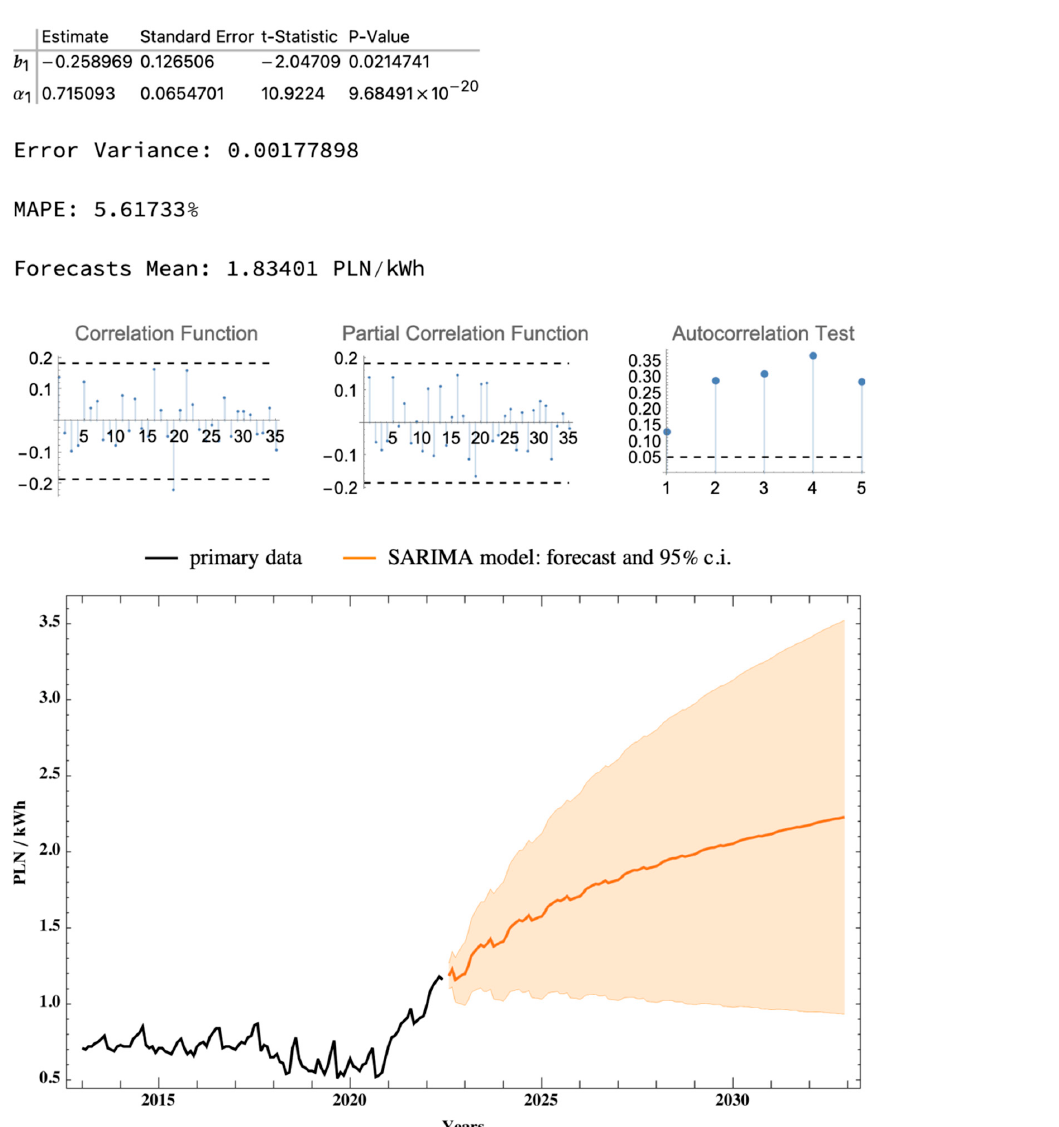
Figure 1. Results of the SARIMA model forecasting electricity prices.